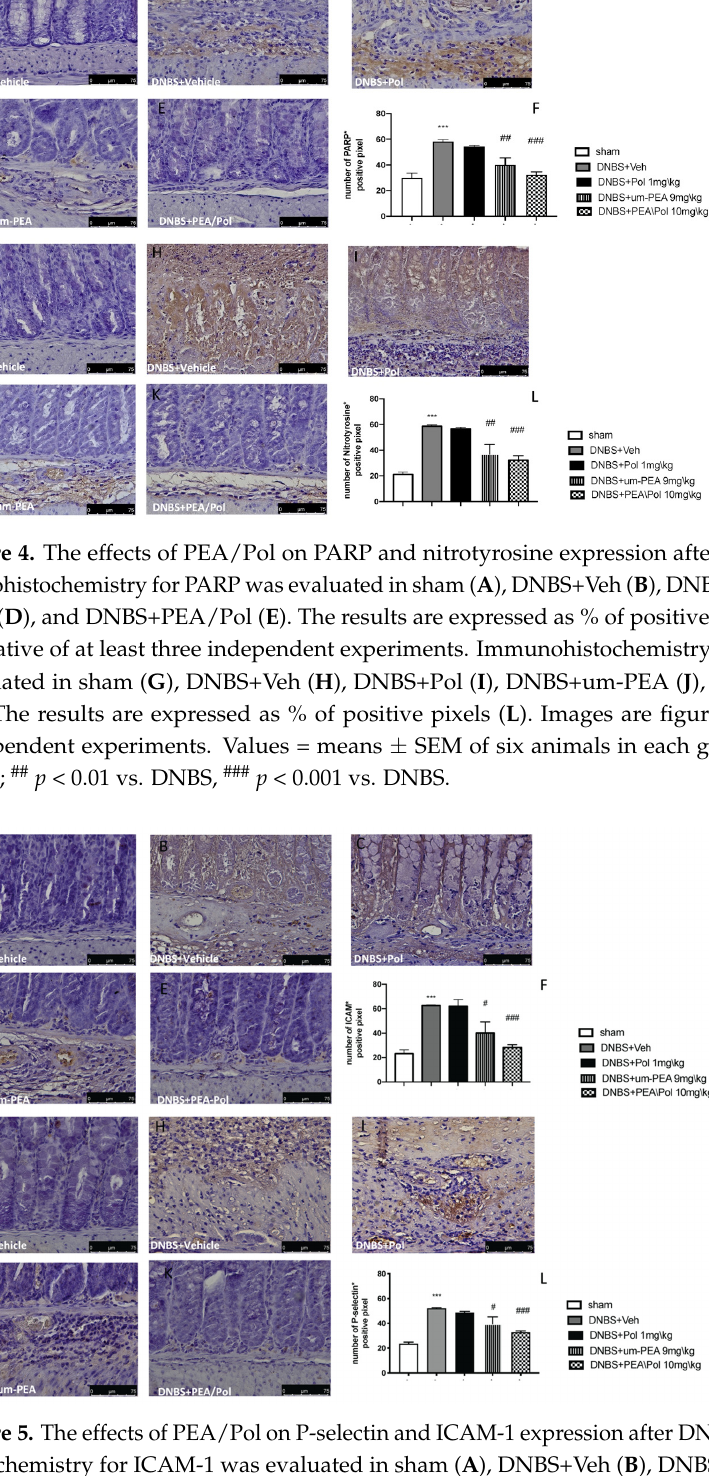
sham; # p < 0.01 vs. DNBS, ### p < 0.001 vs.